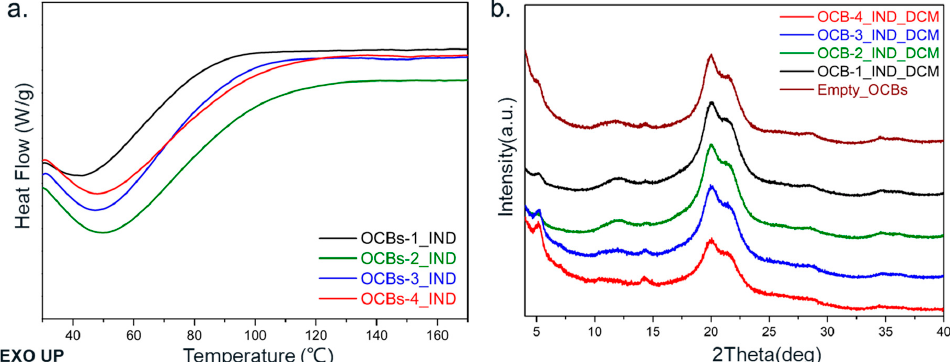
Figure 5. ( a ) DSC thermograms and ( b ) XRPD diffractograms of IND-loaded in OCBs-1 to 4. The baseline curvature in DSC thermograms originates from the evaporation of physically adsorbed water from the cellulose surface. Different results were obtained in the case of FNB. The DSC thermograms of FNB